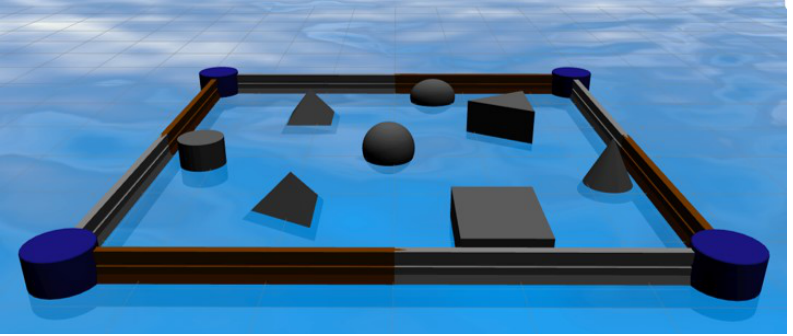
Figure 9. Test environment.